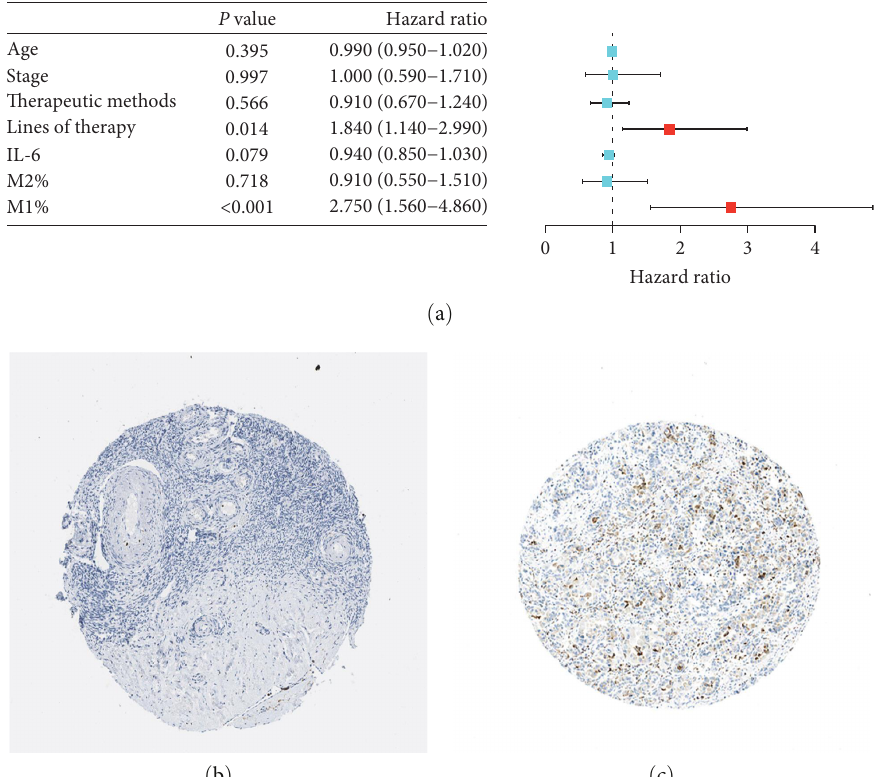
F IGURE 6: The in fl uence factor of PFS and comparison of M2 in fi ltration in tissues. (a) The forest plot of in fl uence factor of PFS by Cox regression. (b) The in fi ltration of M2 in ovarian tissue. (c) The in fi ltration of M2 in ovarian cancer